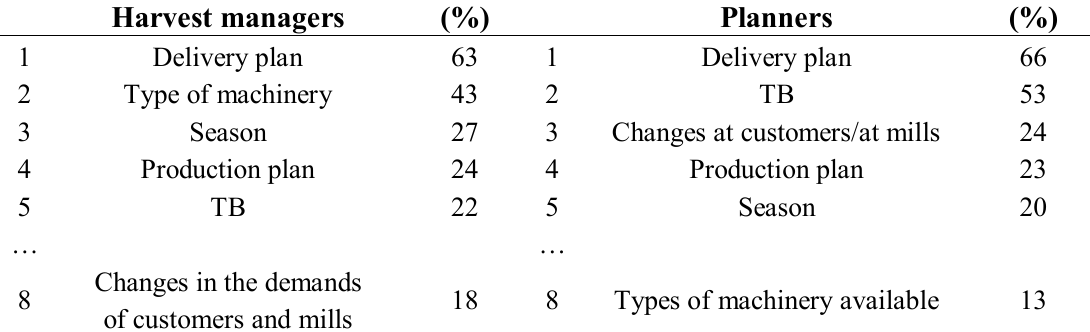
Table 1. The most important factors to consider when making short-term forest plans as identified by harvest managers, and the factors that planners believe forest managers should consider to be most important when making short-term